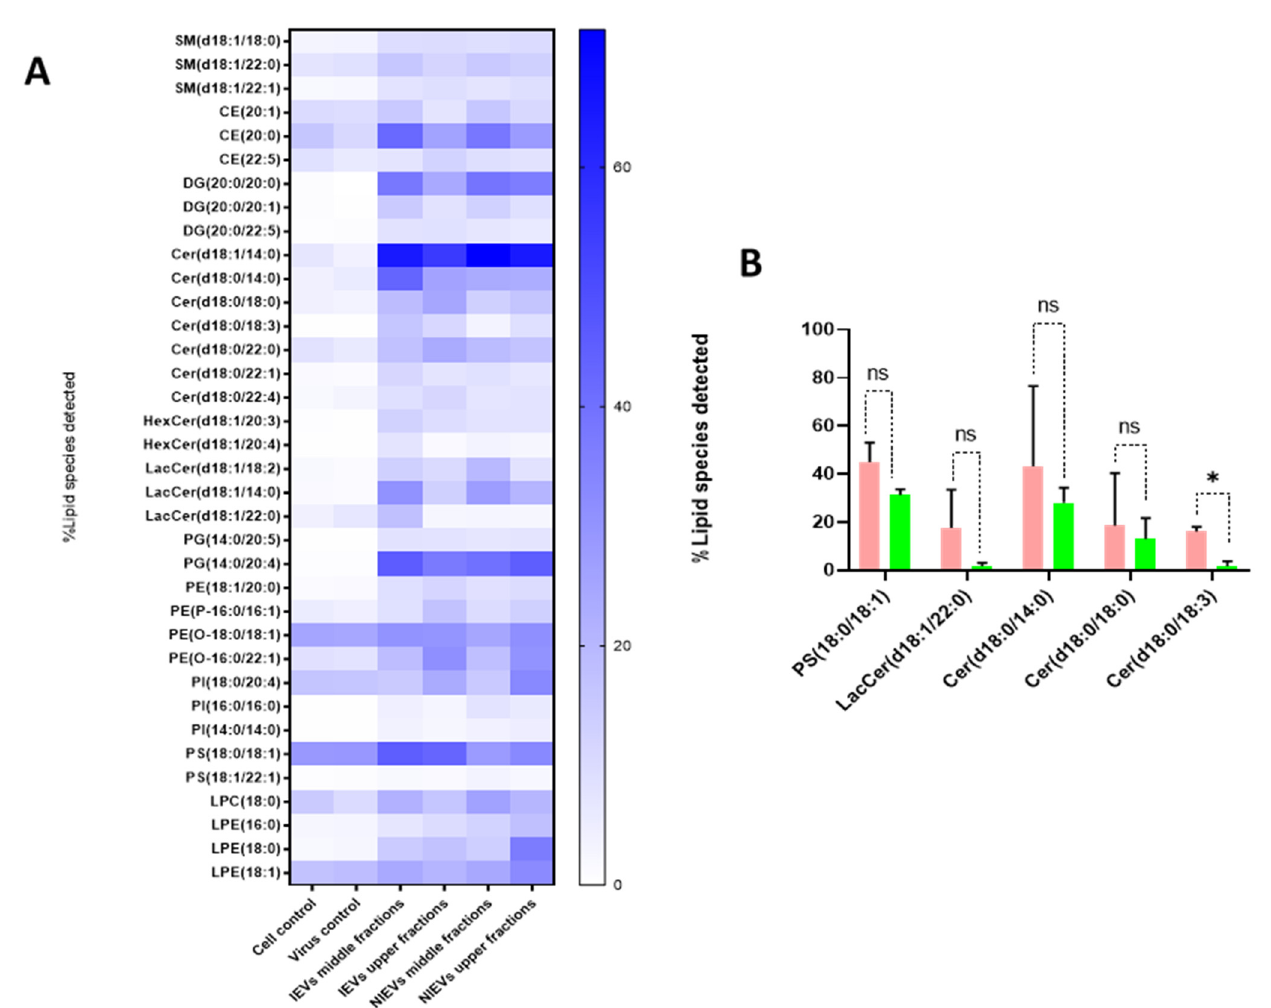
Figure 5. Distinct differences in the lipidomic profile between cell lysates and EV preparations, as well as NIEVs and IEVs. ( A ) Lipidomic heat map showing an increase (in percentage) of molecular lipid species per class into EV preparations, as compared to cell lysates. Each horizontal row represents a molecular lipid and each vertical column represents a sample. Lipid abundance ratios are colored according to their percentage. Colored boxes are used to compare the abundance of lipid species within each different class. ( B ) Five distinct lipid species have shown to be upregulated in infected condition (%mol), but only the levels of Cer(d18:0/18:3) are significantly changed in IEVs (pink), as compared to NIEVs (green) ( p < 0.05). SM: sphingomyelin, CE: cholesteryl ester, DG: diacylglycerol, Cer: ceramide, LacCer: lactosylceramide, HexCer: hexosylceramide, PG: phosphatidylglycerol, PE: phosphatidylethanolamine, PI: phosphatidylinositol, PS: glycerophos- phoserine, LPC: lysophosphatidylcholine, LPE: lysophosphatidylethanolamine. Data shown are from 3 independent ex- periments (mean ± SD values). Significance is calculated based on p -values. ns: p > 0.05, * p < 0.05.